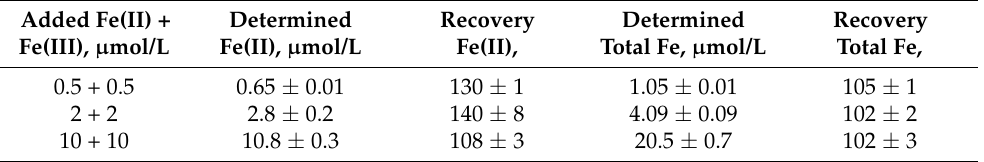
Table 2. Determination of iron in spiked artificial cloudwater by µ